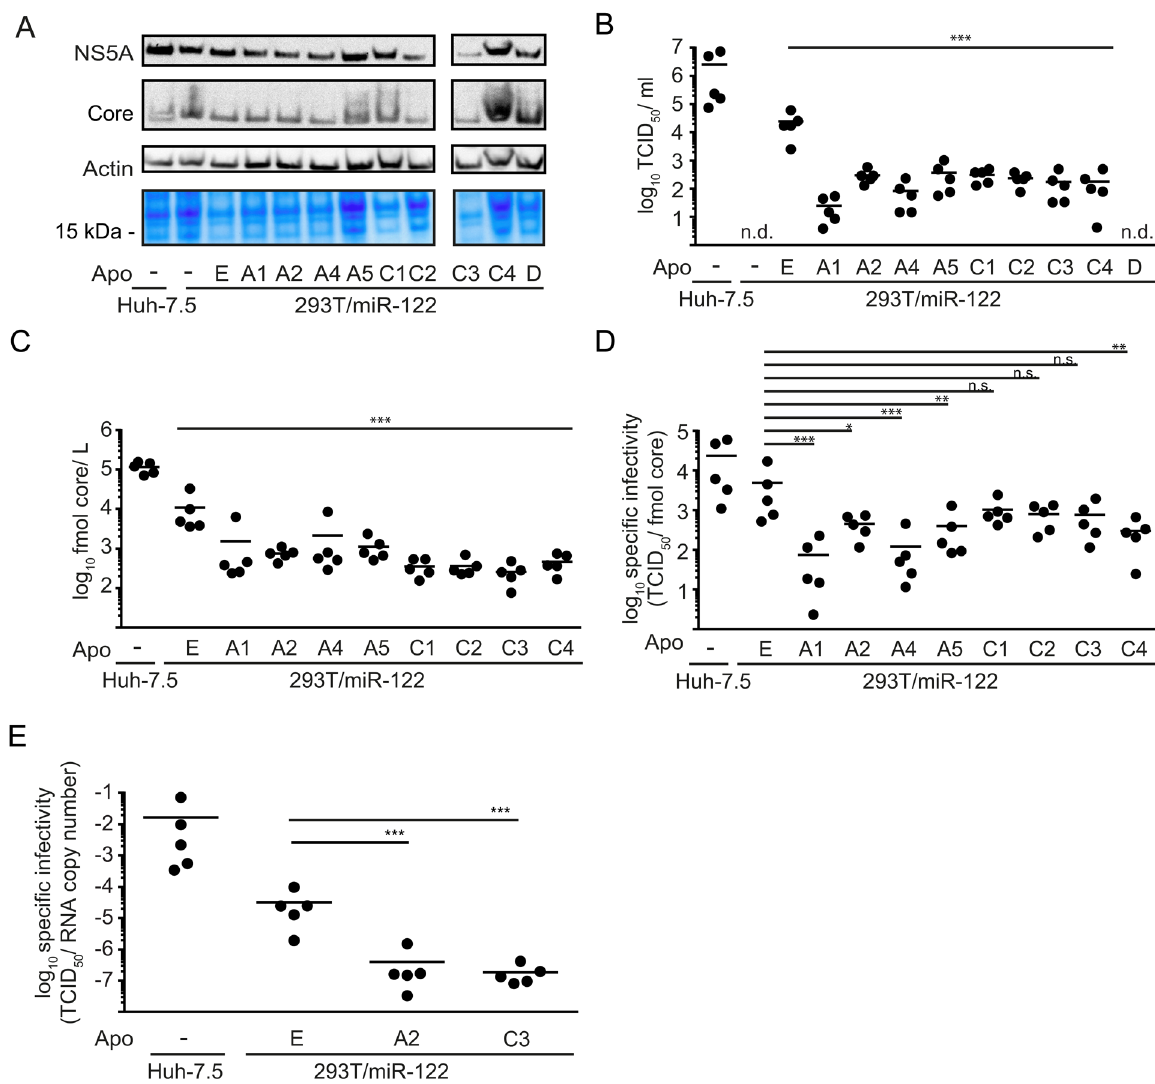
Fig 3. Expression of ApoA and ApoC protein family members complements HCV morphogenesis with reduced efficiency compared to ApoE. A: HCV RNA (Jc1 wt) was used to transfect indicated cell lines. Expression of viral and cellular proteins was verified by Western blot using antibodies against core, NS5A and β -actin. Additionally, total protein content was visualized by Coomassie staining. B: To assess production of infectious virus particles, supernatants were used to infect na ï ve Huh-7.5 cells to determine the titer by endpoint dilution assay (TCID 50 / ml). C: Secretion of core protein into the cell culture supernatant was quantified by core-specific ELISA. Results are shown as fmol core/ L D: Specific infectivity of HCV particles released from the indicated cell lines was calculated based on the data presented in panel (B) and (C) and is given as TCID 50 / fmol core. E : Specific infectivity was additionally calculated for a selection of cell lines based on RNA copy number released into the supernatant and corresponding TCID 50 values. For (A), (B), (C), (D) and (E), all samples were taken 48 h post transfection and each data point represents an individual experiment while the mean is depicted as a dash. Statistical analyses in these panels were performed by Dunnett ’ s multicomparison test. Significant changes in infectivity, core secretion or specific infectivity of cells expressing other apolipoproteins compared to ApoE are indicated ( *** = p < 0.001, ** = p < 0.01, * = p < 0.05). n. s. = non-significant (p > 0.05), n. d. =